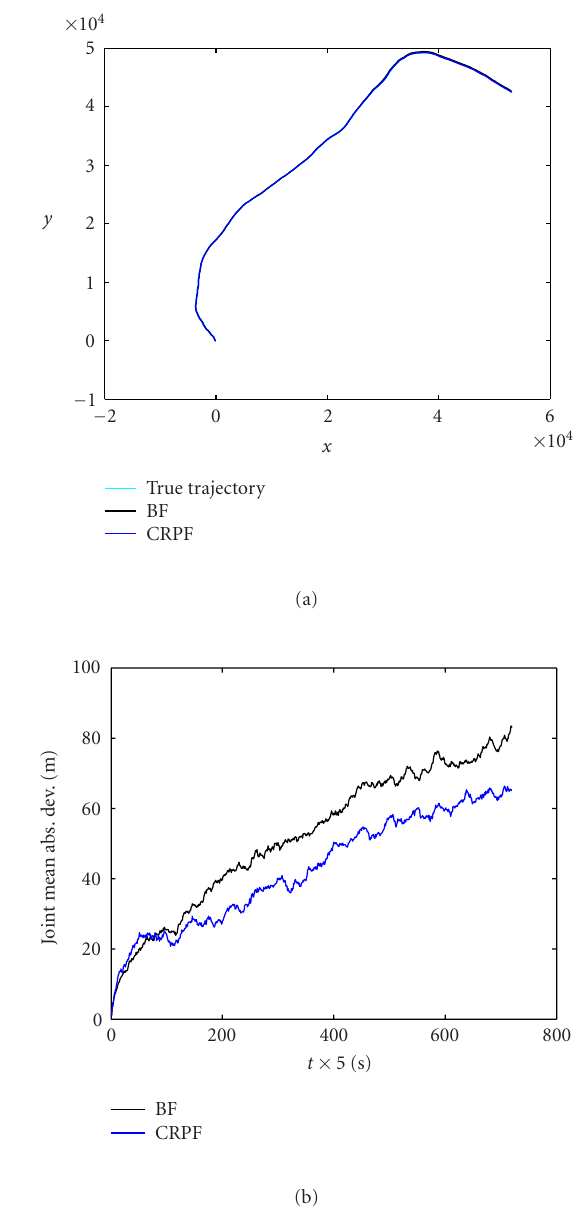
Figure 9: Laplacian. T s = 5s. (a) Trajectory. (b) Mean absolute